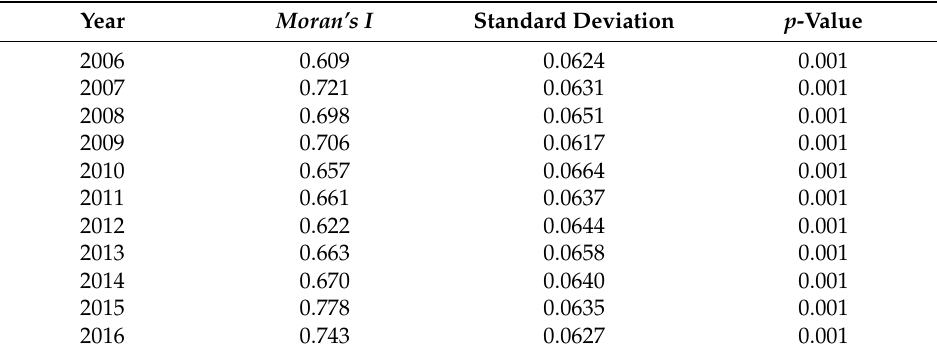
Table 2. Global Moran’s I